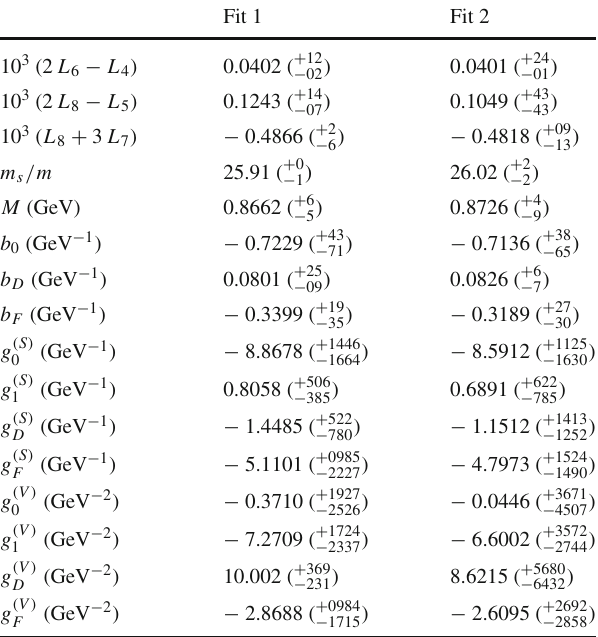
Table 1 Results for LEC in (1,2) based on two fit scenarios. The low- energy constants L n are at the renormalization scale μ = 0 . 77 GeV. We use f (cid:3) 92 . 4 MeV and F (cid:3) 0 . 48 , D (cid:3) 0 . 75 throughout this